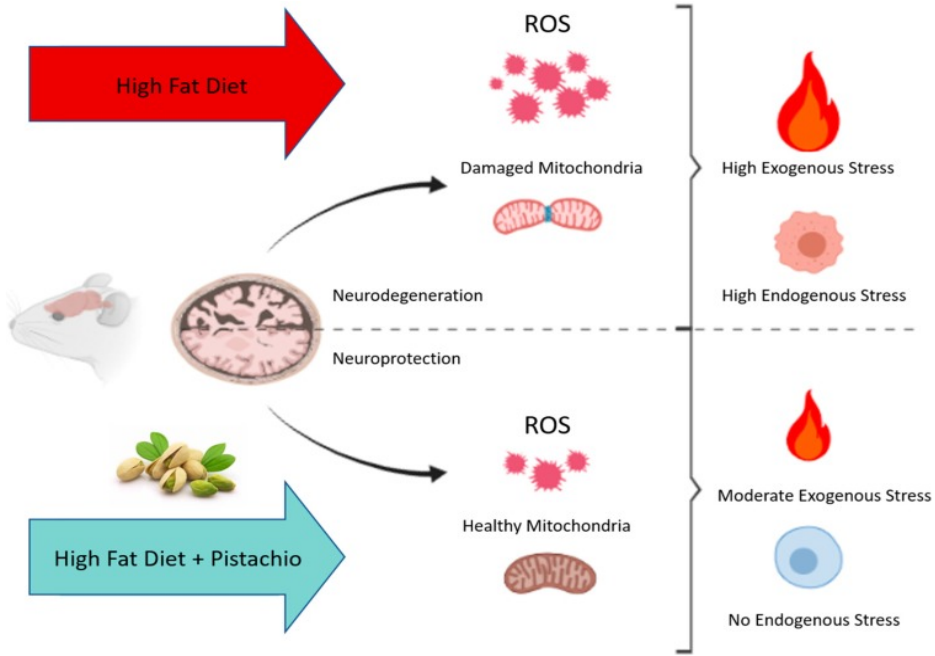
Figure 4. The neurodegenerated effects of a high-fat diet in comparison with the neuroprotective effects of regular consumption of pistachio [29].